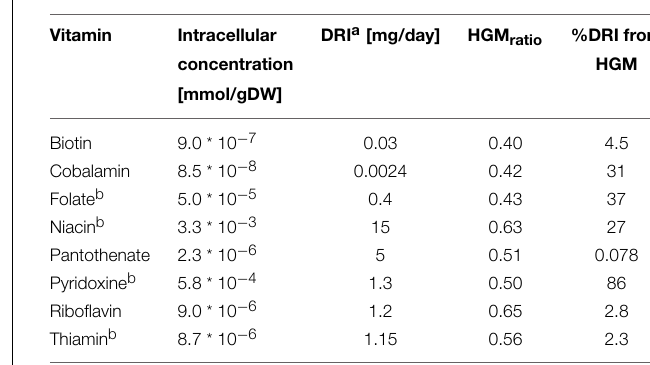
TABLE 5 | Estimated maximal percentage of daily reference intake of the eight vitamins that could be provided by the human gut microbiota.